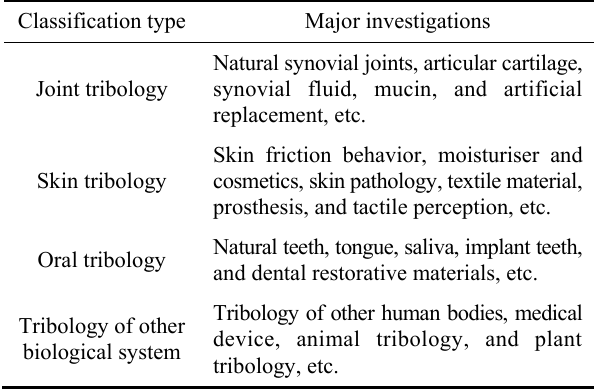
Table 1 Summary of major topics in biotribology research, including joint, skin, oral, and other systems.